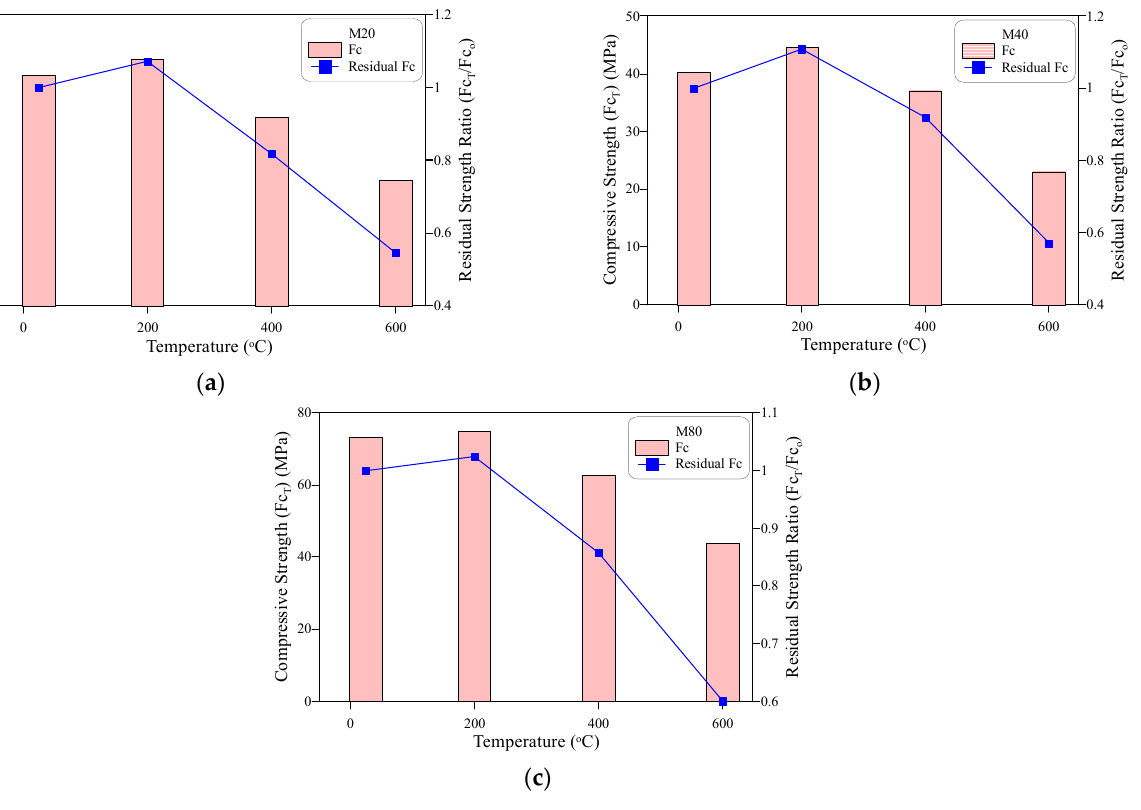
Figure 6. Compressive strength at different temperatures: ( a ) M20, ( b ) M40, ( c ) M80.